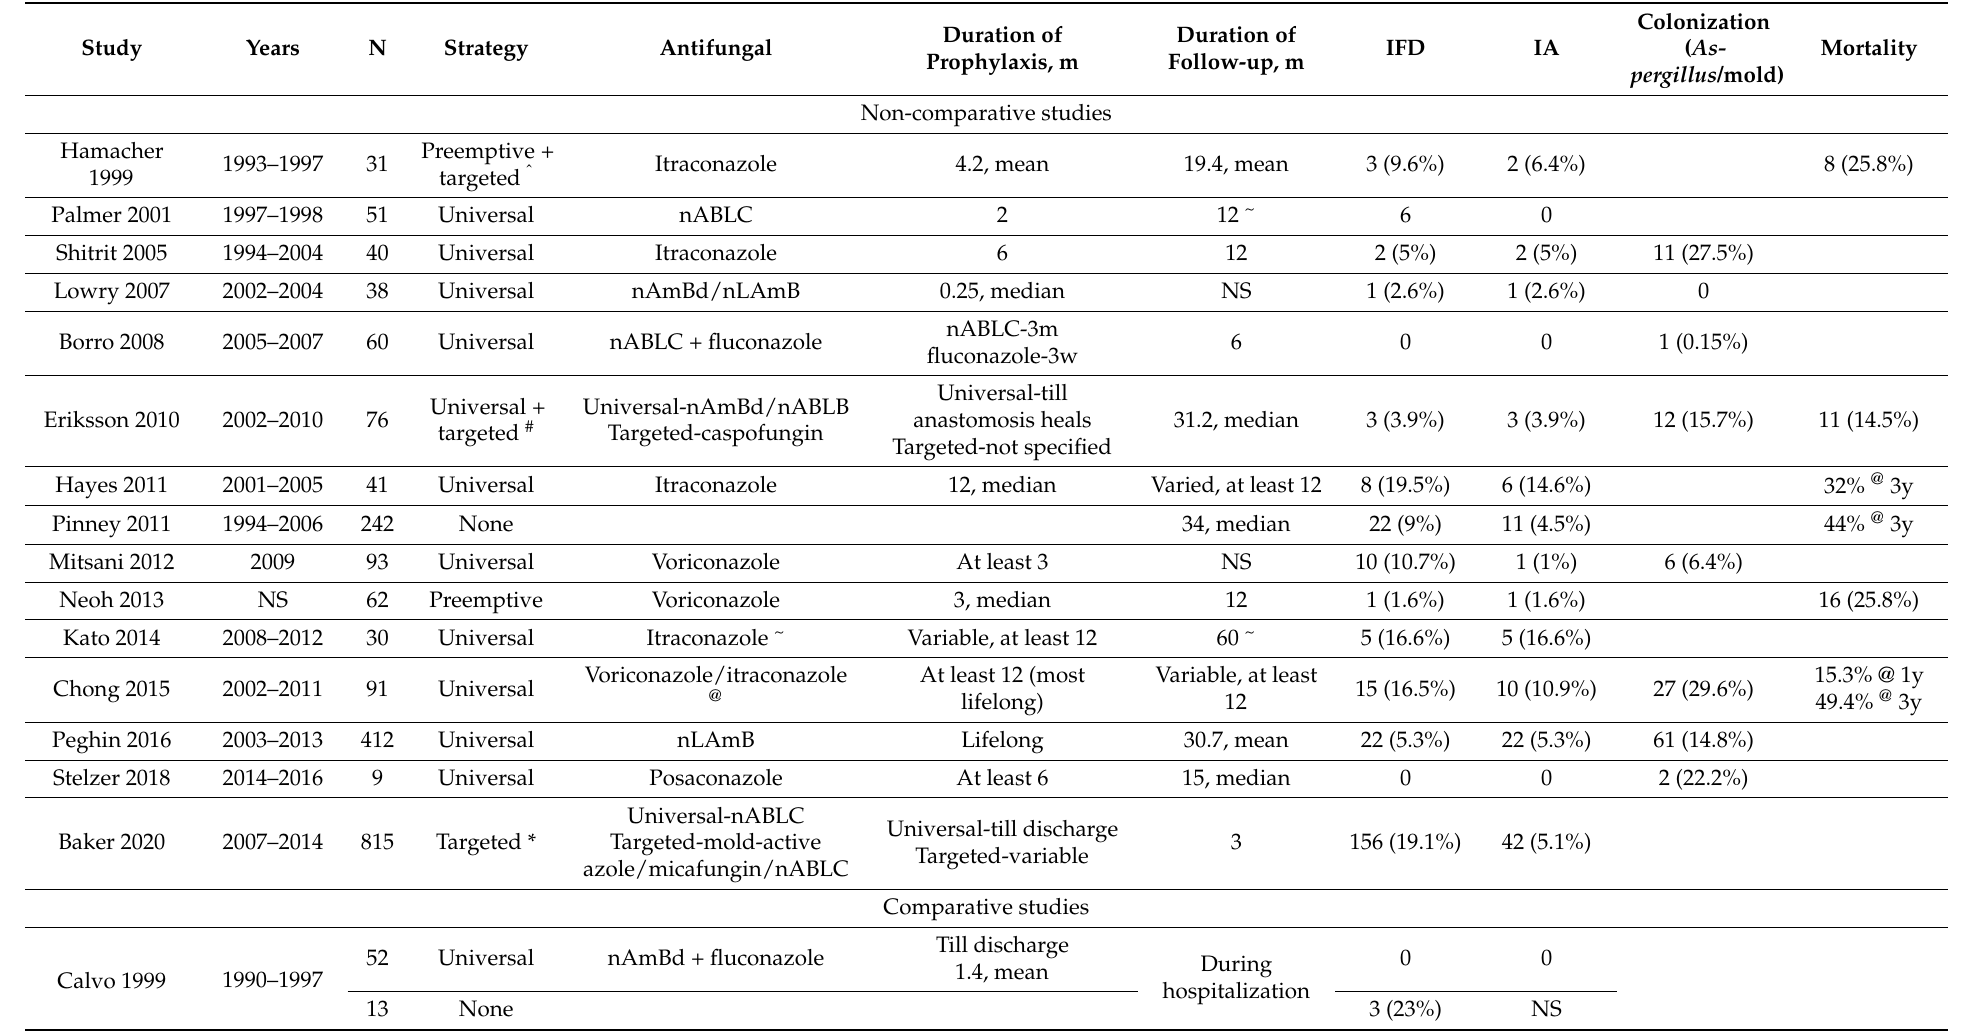
Table 1. Studies evaluating preventive strategies for fungal disease in lung transplant